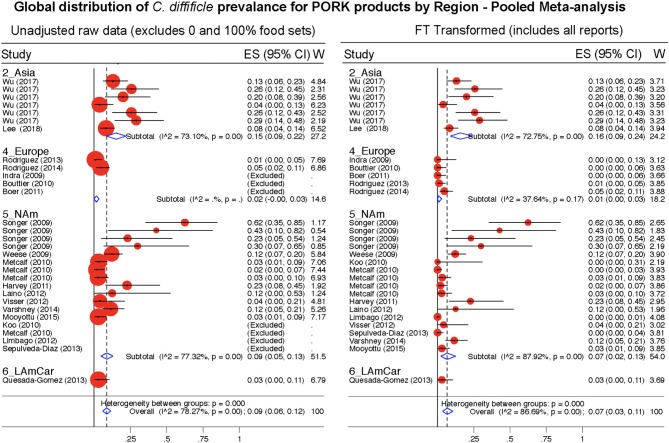
Global Prevalence of C. difficile in Pork. Untransformed data (left) and Freeman-Tukey Double Arcsine Transformation (right).